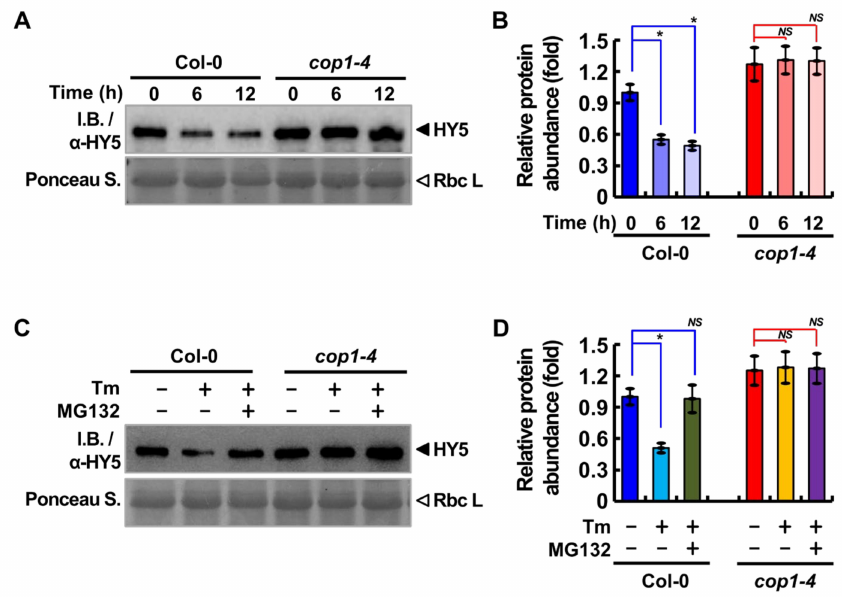
Figure 4. COP1-mediated partial degradation of HY5 under ER stress. ( A ) Time-dependent degrada- tion of HY5 in WT (Col-0) and cop1-4 plants after Tm treatment. Total proteins were extracted from 10-day-old seedlings treated with 5 µ g/mL Tm for 0, 6, and 12 h through vacuum infiltration, and HY5 was detected by immunoblotting with anti-HY5 antibody. ( B ) Quantification of the relative abundance of HY5 protein in the blots shown in ( A ). The amount of HY5 detected in WT and cop1-4 seedlings at the 6 and 12 h time points was normalized relative to that detected in WT seedlings at the 0 h time point (control condition). ( C ) Confirmation of proteasome-mediated HY5 degradation. Total proteins were extracted from 10-day-old WT (Col-0) and cop1-4 seedlings subjected to treat- ment with (+) or without ( − ) 5 µ g/mL Tm for 6 h, followed by treatment with (+) or without ( − ) 50 µ M MG132. The HY5 protein was detected by immunoblotting analysis with anti-HY5 antibody. ( D ) Quantification of the relative abundance of HY5 protein samples shown in ( C ). Data at each time point were normalized relative to the control condition (Col-0, − Tm, − MG132). In ( B , D ), data represent ± standard error of mean (SEM) of three independent biological replicates. Asterisks indicate statistically significant differences (Student’s t -test; * p < 0.05; NS , not